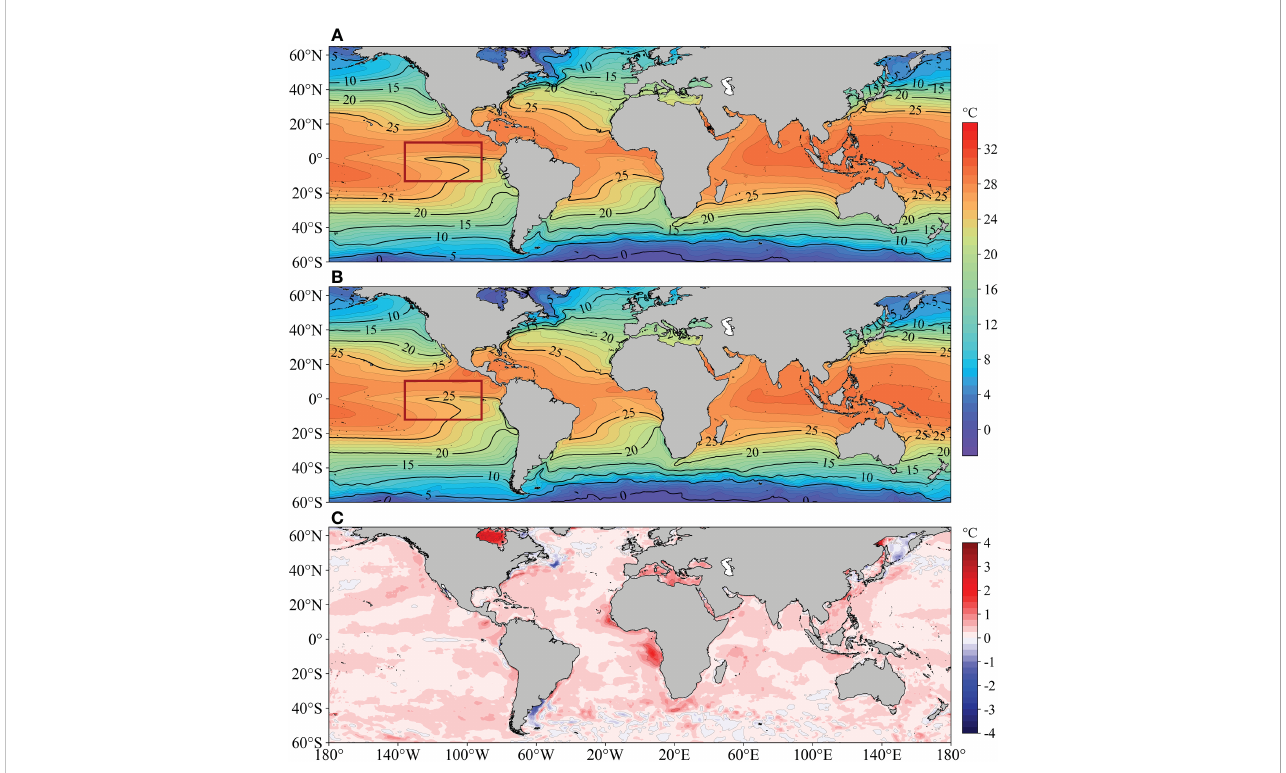
FIGURE 8 Global climatic (1994~2017) SST distribution of (A) ODF-ST dataset, (B) OISST, and (C) their